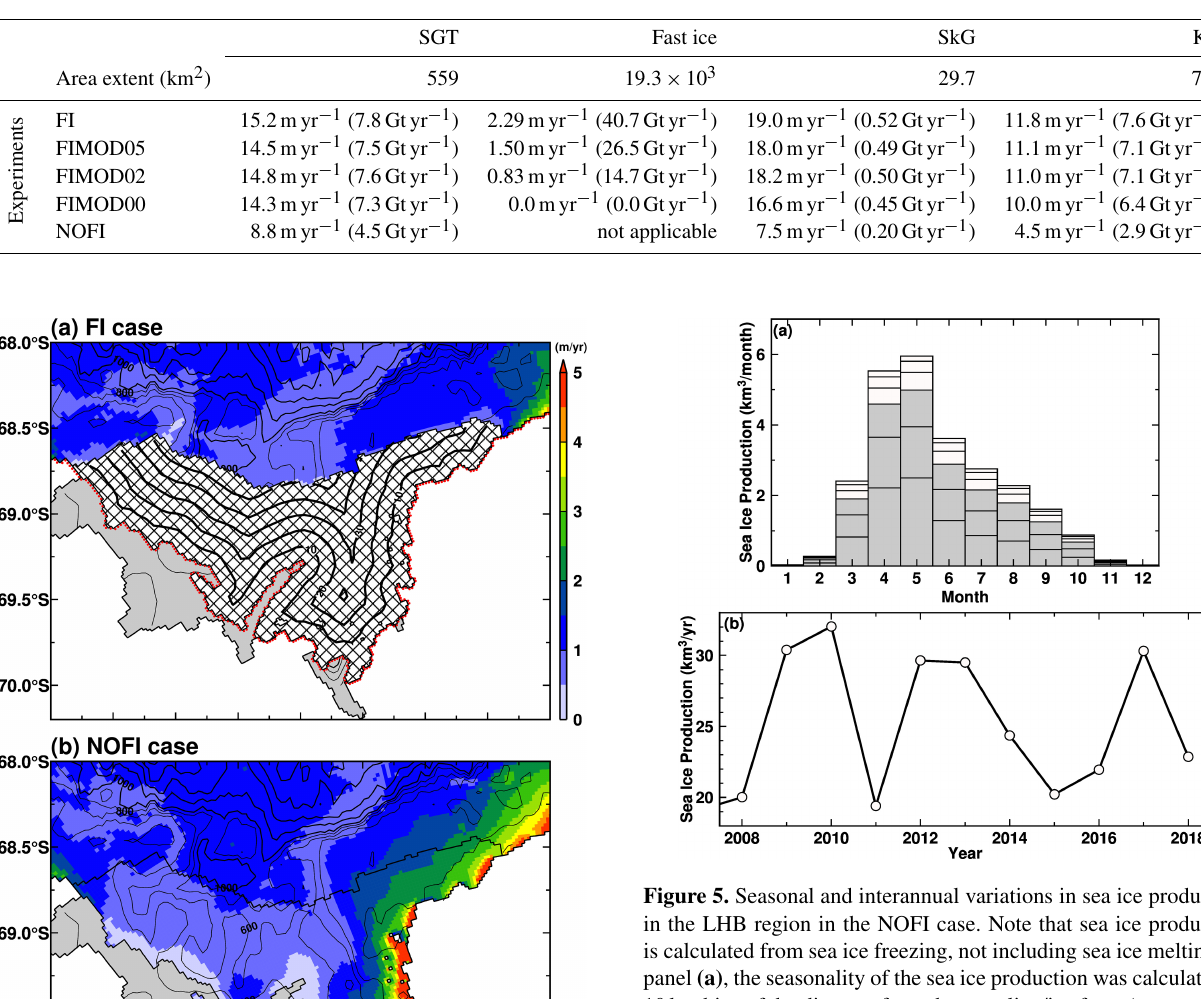
Table 1. Annual mean basal melt rate (myr − 1 ) and amount (Gtyr − 1 ) at glaciers in the LHB and fast ice. SGT indicates the Shirase Glacier tongue; SkG indicates Skallen Glacier; KG indicates Kaya Glacier.